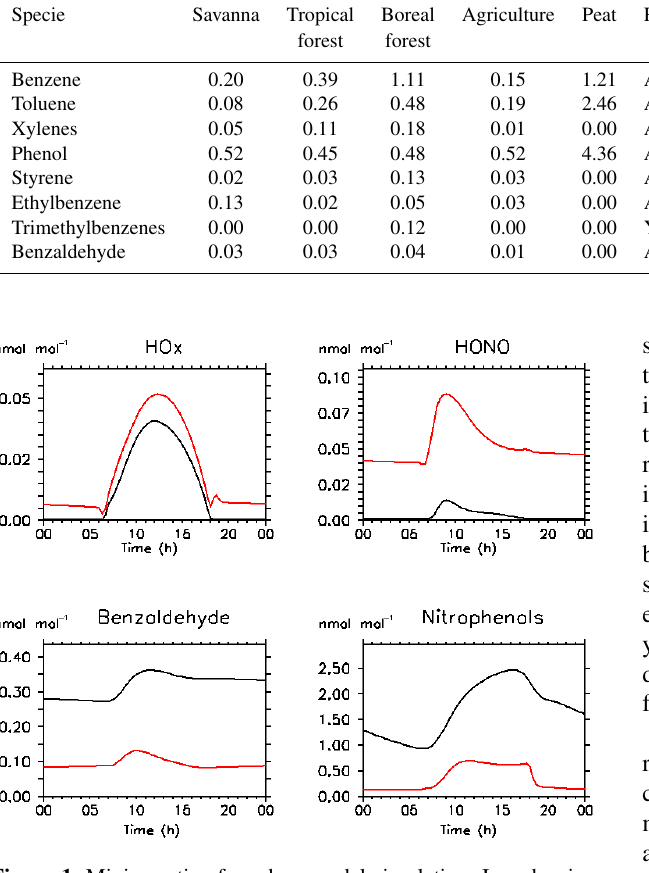
Figure 1. Mixing ratios from box model simulation. In red, mix- ing ratios from the mechanism used in this work. In black, mixing rations from the same mechanism without the updated photolysis rates for benzaldehyde and the new photolysis channels for nitro-